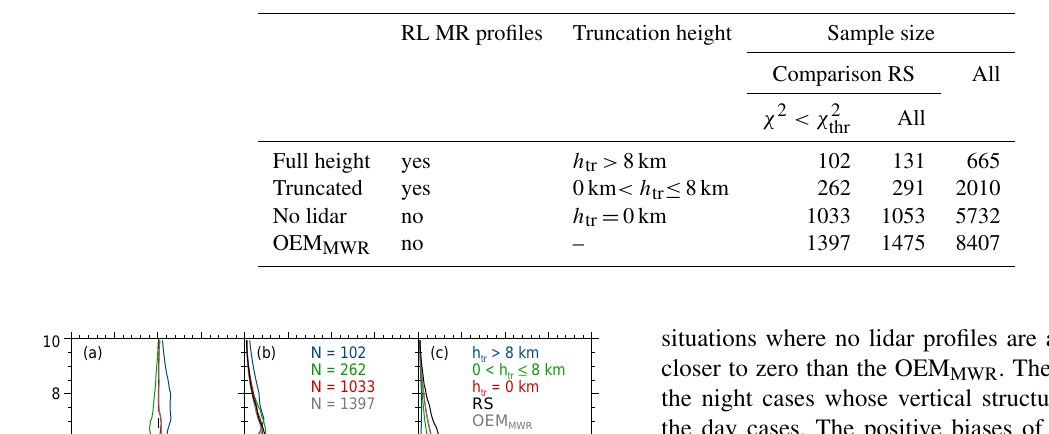
Table 2. Overview of the different situations depending on Raman lidar mixing ratio (RL MR) profile availability and truncation height ( h tr ) where the RL MR profile is truncated (due to clouds). The three columns on the right indicate the sample size used for the comparison with radiosonde (RS), to validate the retrieved profiles, and all cases. Furthermore, the profiles that are used for the comparison with RS are separated between those passing and failing the χ 2 test based on a threshold χ 2 . The temporal resolution of the retrieved profiles amounts thr to 5min.